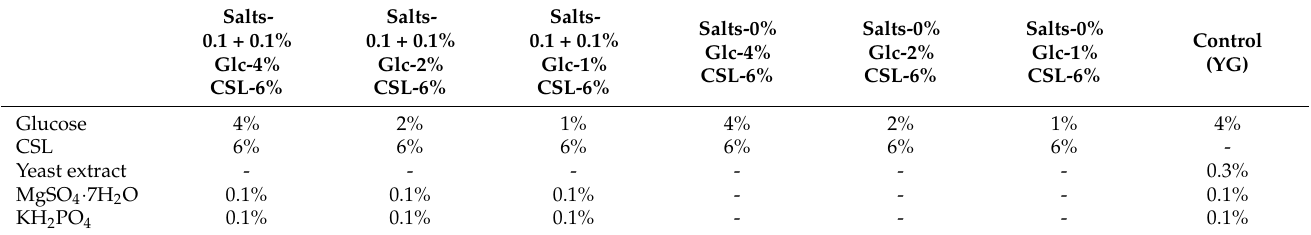
Table 4. Compositions of the CSL-6% media with reduced concentrations of glucose and inorganic salts. All media were adjusted to a pH of 5.5 ±